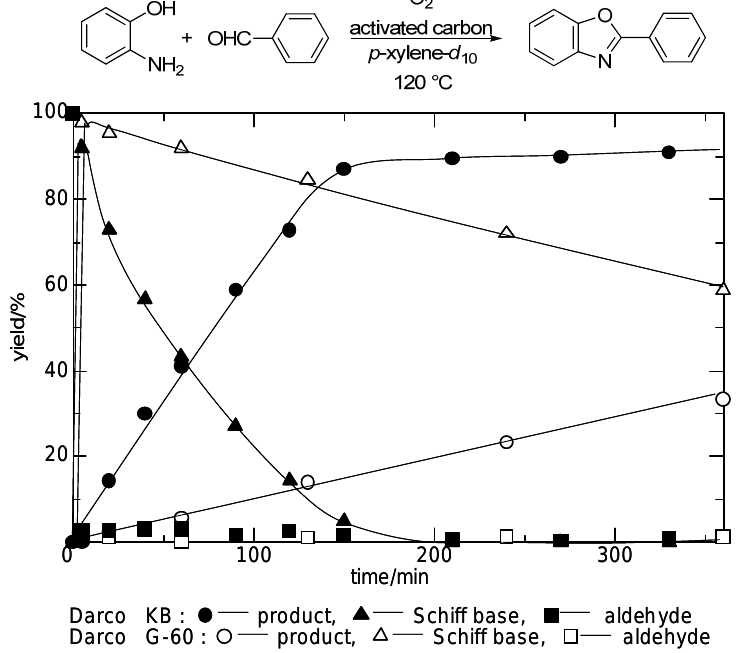
Figure 1. Time course of 2-phenylbenzoxazole, Schiff base, and aldehyde using activated carbon as catalysts which have different properties as shown in Table 9, were